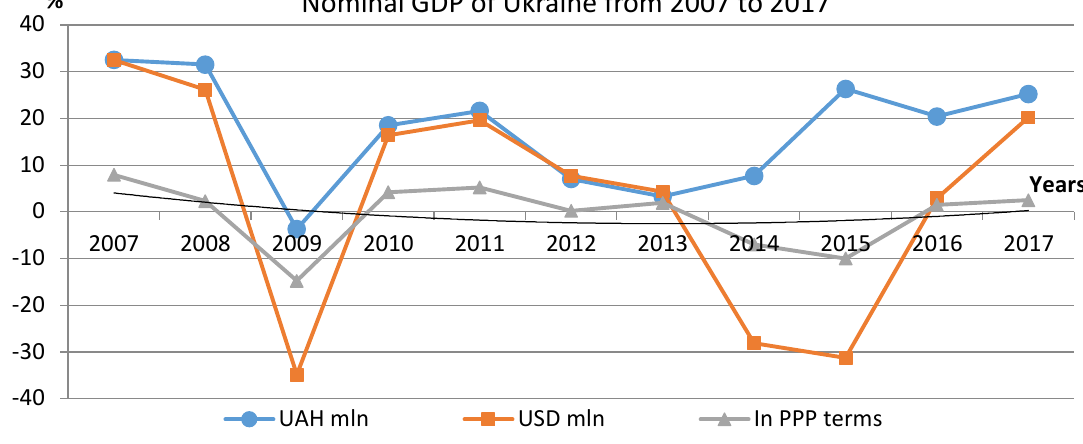
Figure 2. Comparing the GDP dynamics according to different calculation